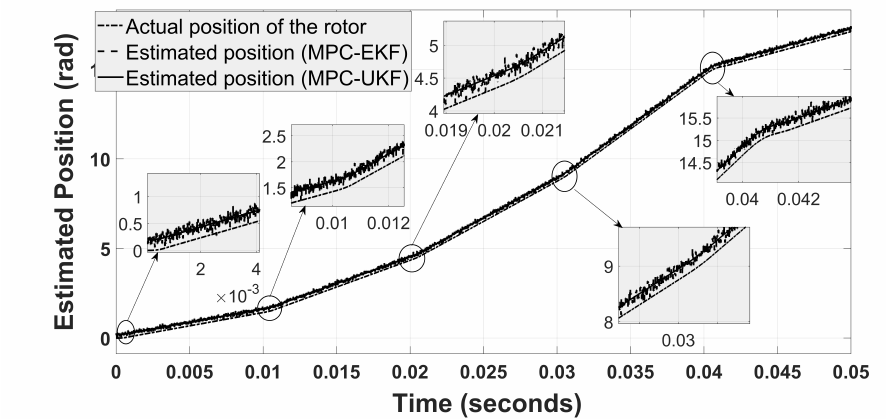
Figure 14. Position estimation comparison for MPC-UKF and MPC-EKF.